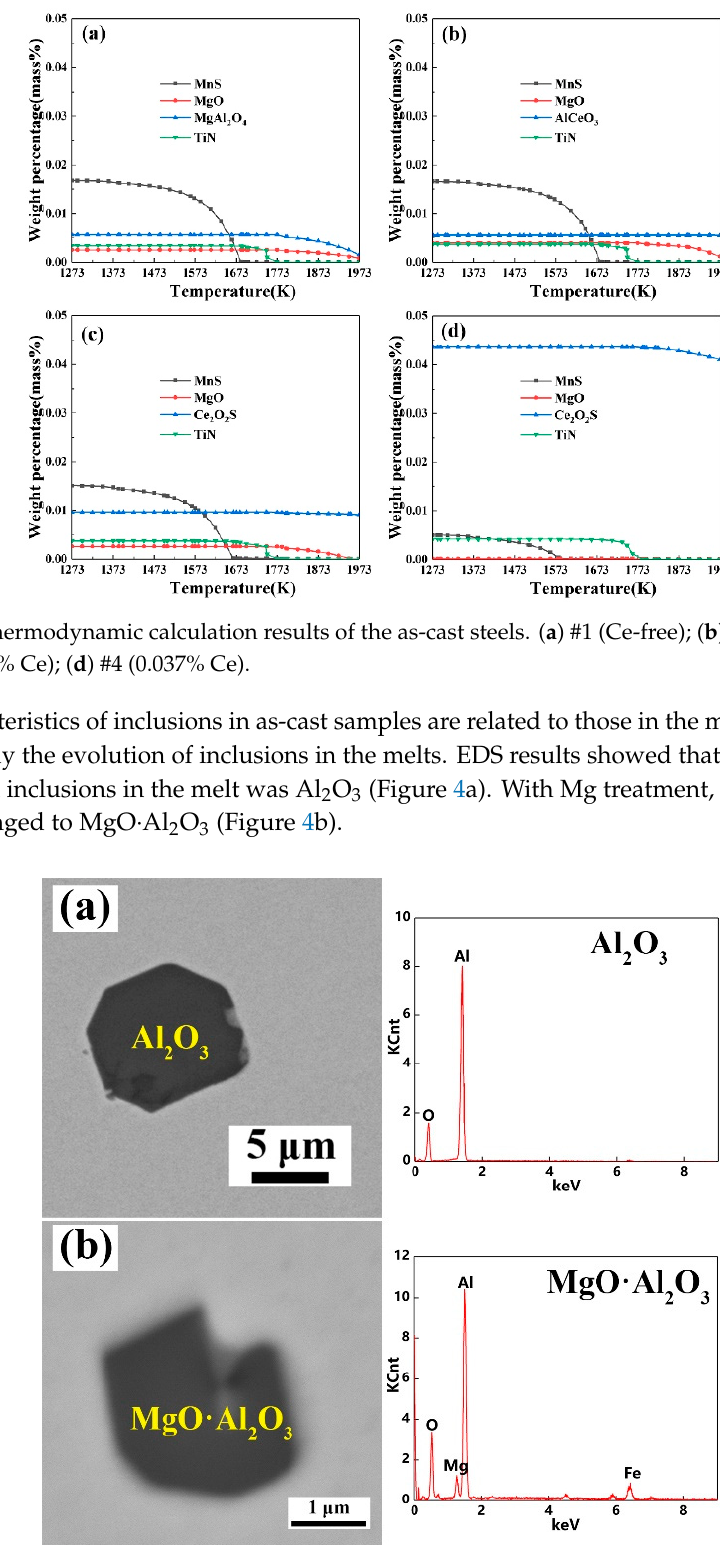
Figure 4. Main inclusions in the melts. ( a ) A-1 and ( b ) A-2.